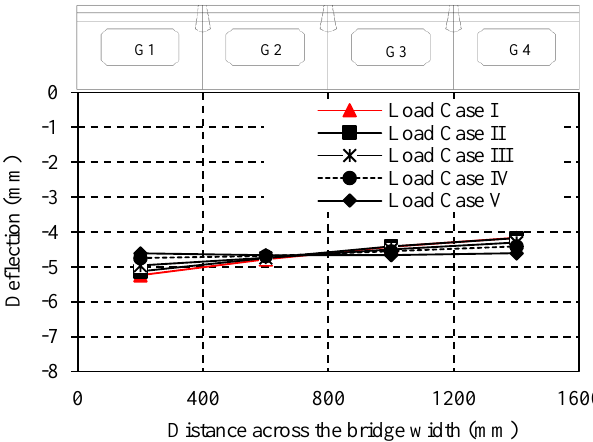
Figure 14. Mid-span deflection profile for different wheel locations.